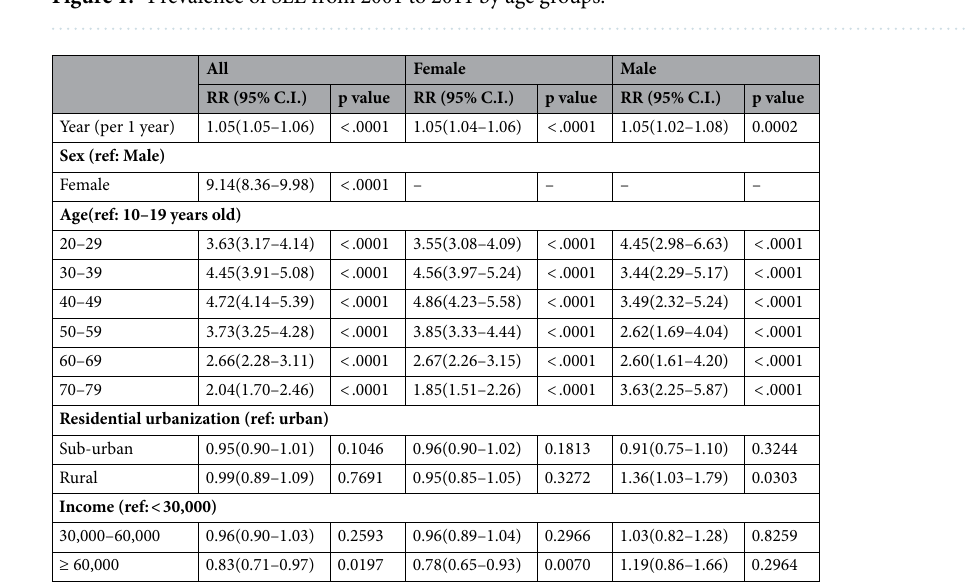
Figure 1. Prevalence of SLE from 2001 to 2011 by age groups.